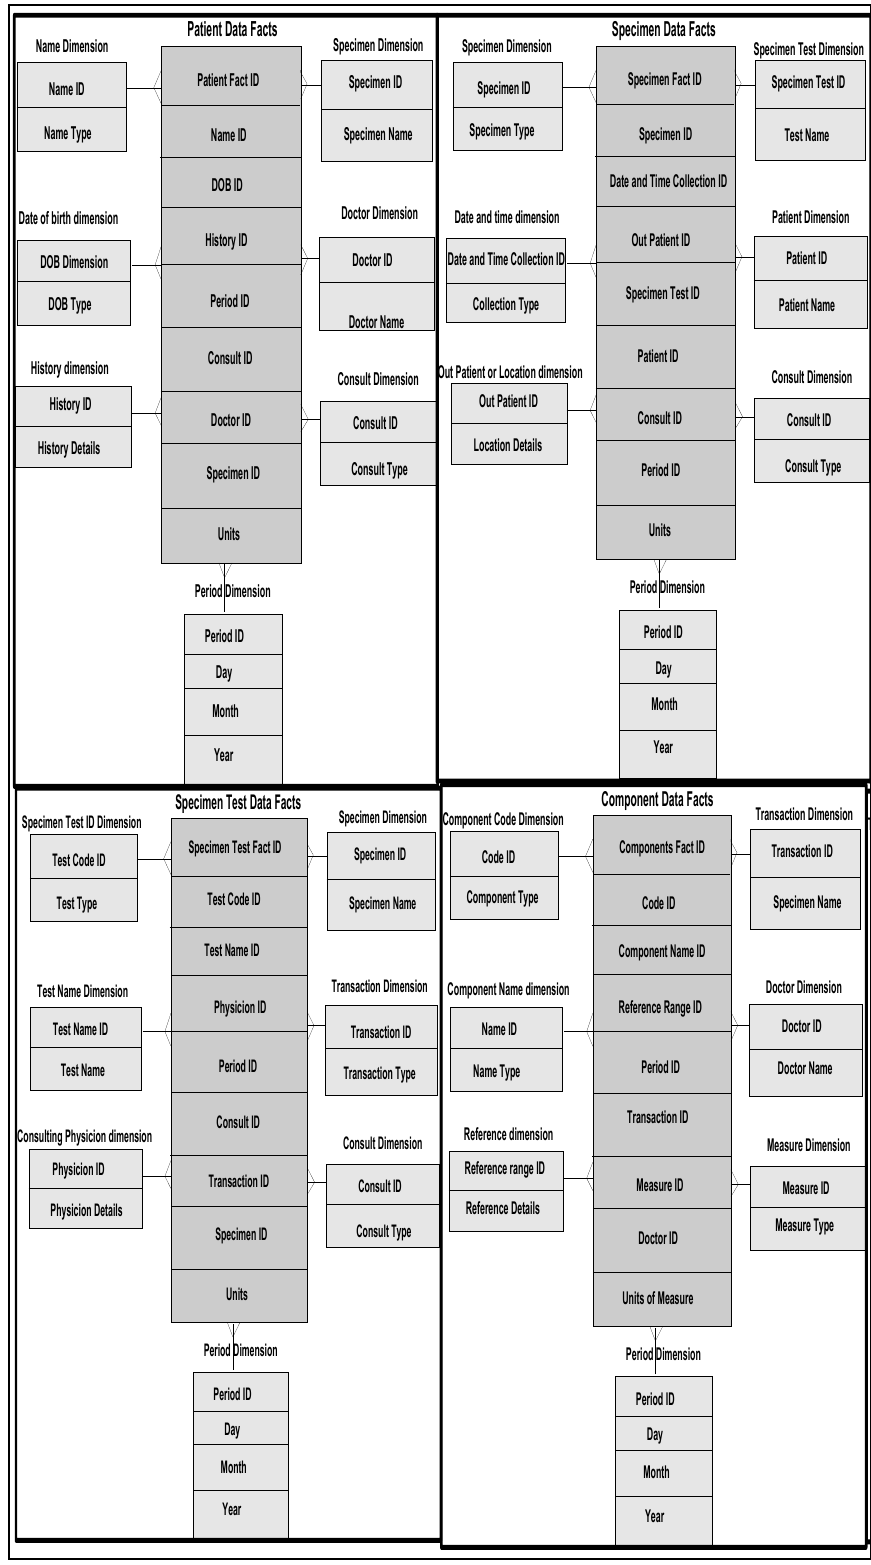
Figure 3. ( a ) Heterogeneous data and their connectivity, modelling patients and specimen dimensions that narrate clinical histories of diabetics disease. ( b ) Sensitivity and other transactional multidimensional data modelling that narrate clinical histories of